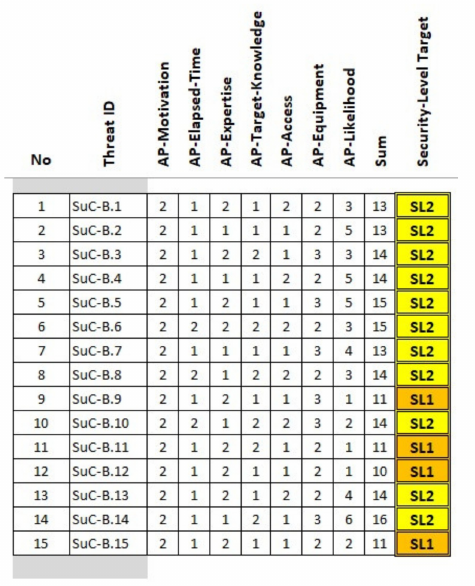
Figure 6. Cybersecurity risk analysis table, Part